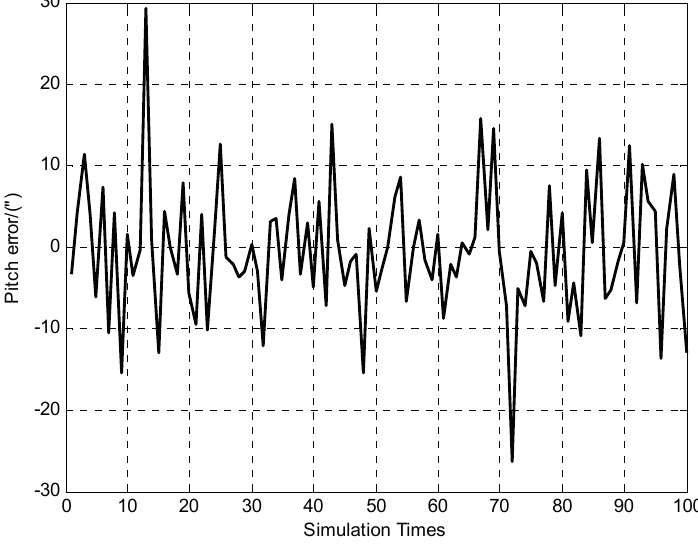
Figure 7. 100 times of pitch error determination results.